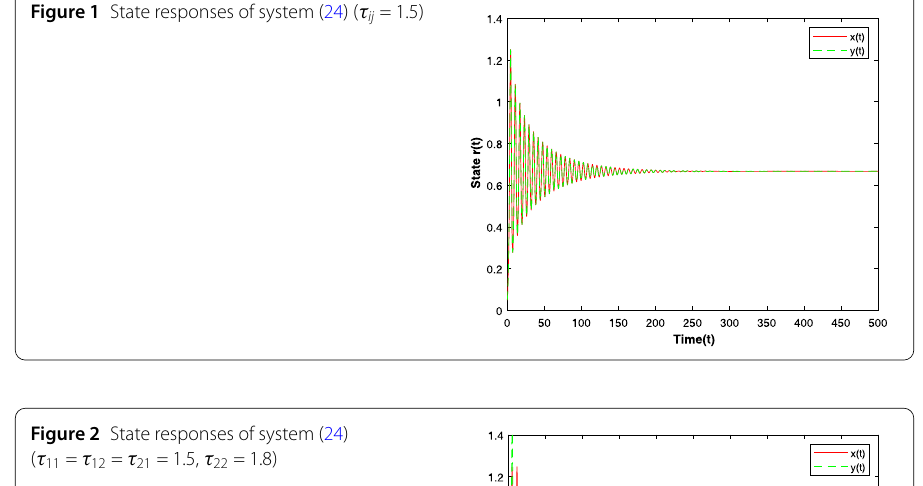
Figure 2 State responses of system (24) ( τ 11 = τ 12 = τ 21 = 1.5, τ 22 =